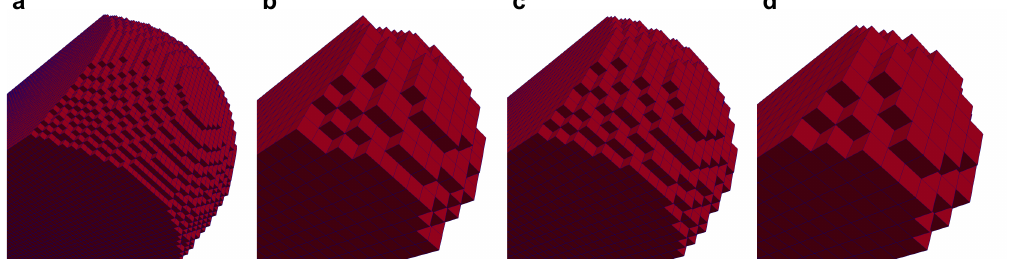
Figure 8. Examples of the synthetic voxelized data resampled from the simulated phase distribution for a contact angle of θ = 45 ◦ for grid sizes of ( a ) ∆ = 1, ( b ) 2, ( c ) 3 and ( d ) 4 µ